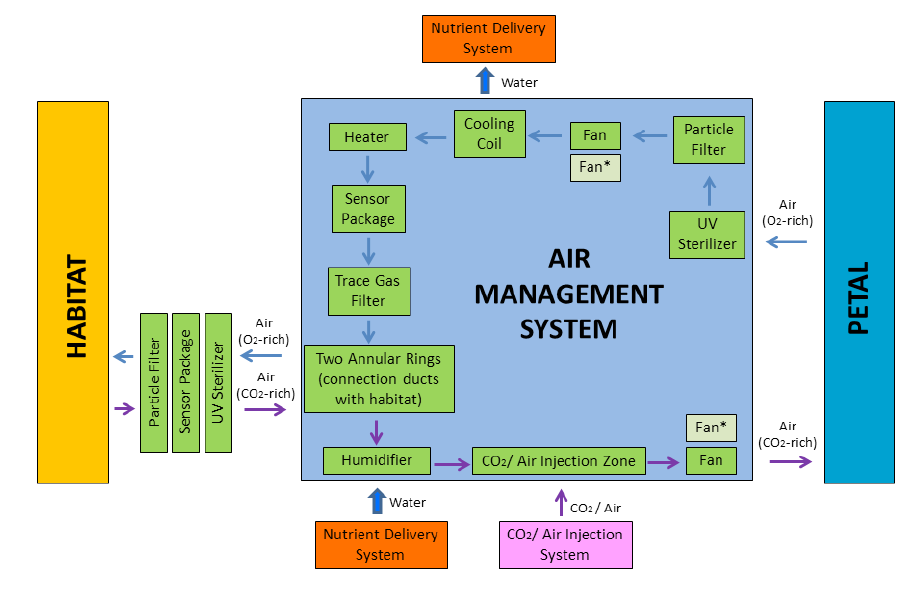
Figure 12: Air path and the position of the different components of the AMS for a single petal (*redundant